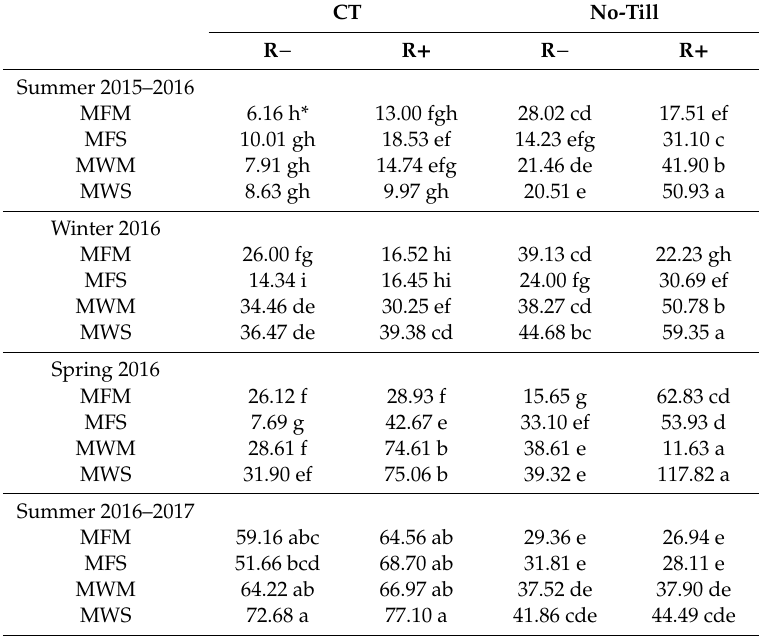
Table 6. Tillage × crop rotation × residue management e ff ects on the ash-free dry biomass (g m − 2 )